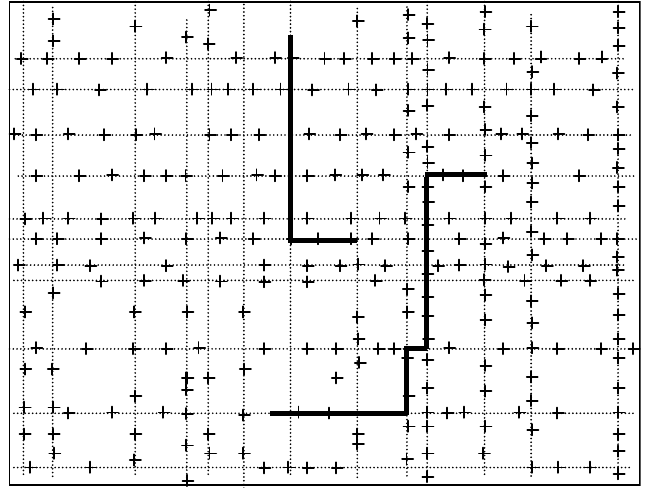
Figure 1. Traveling pattern of the moving node in our network